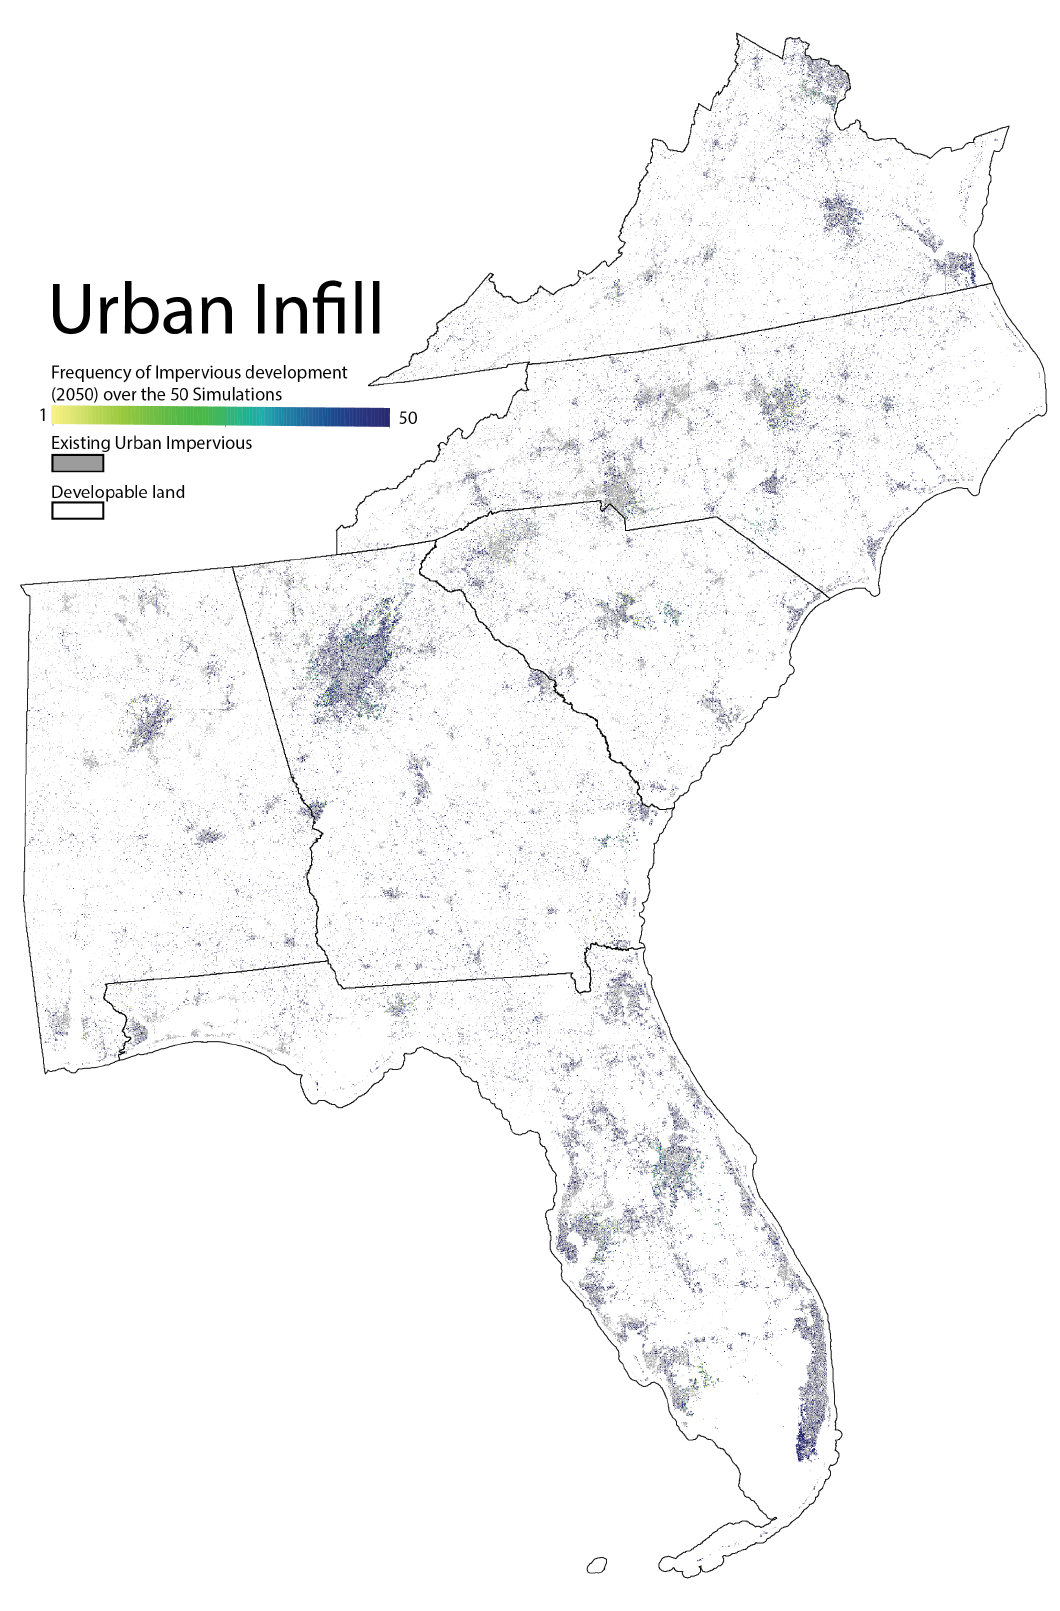
Figure A2. High resolution (30 m) development frequency map of an urban infill development